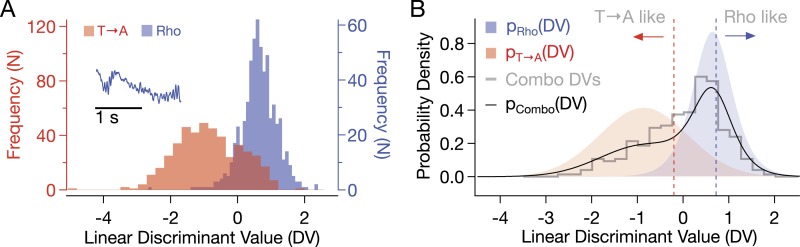
Combo rod responses were classified according to similarity to a template that discriminated between Rho and T → A responses (inset).To find the template, principal component analysis was performed on the response matrix R, with WT and T → A responses of 1810 time samples each (rows) forming the columns. The responses were projected into the subspace spanned by the 21 eigenvalues and eigenvectors accounting for 99% of the variance. A linear discriminant, w, was calculated as:w=Sw−1(m1−m2),where mi is the mean of responses × in a class, Di, and Sw is the sum of the within-class scatter matrices, Si given by:Si=∑x∈Di(x−mi)(x−mi)t,where t indicates the vector transpose (Duda et al., 2001; Chang et al., 2012). (A) Discriminant values (DVs) of pure T → A and Rho responses. Correlating the initial response phase with the template gives the linear DV. This discriminant gives the lowest misclassification error (Bayes Error). T → A DVs were fit with a Gaussian probability density function (PDF) (μ = −0.86, σ = 0.96, p(χ2) = 0.321). Rho DVs were fit with a logistic PDF (μ = 0.64, σ = = 0.29, p(χ2) = 0.971). PDFs are plotted in (B). (B) The probability density of combo rod response DVs was fit with a linear combination of T → A and Rho PDFs: pCombo = c*pRho + (1 − c) pT → A, where c = 0.55 (black line, p(χ2) = 0.068). Vertical red line indicates DV values such that only 5% of Rho responses would receive a lower DV value. Blue line indicates the same for T → A.